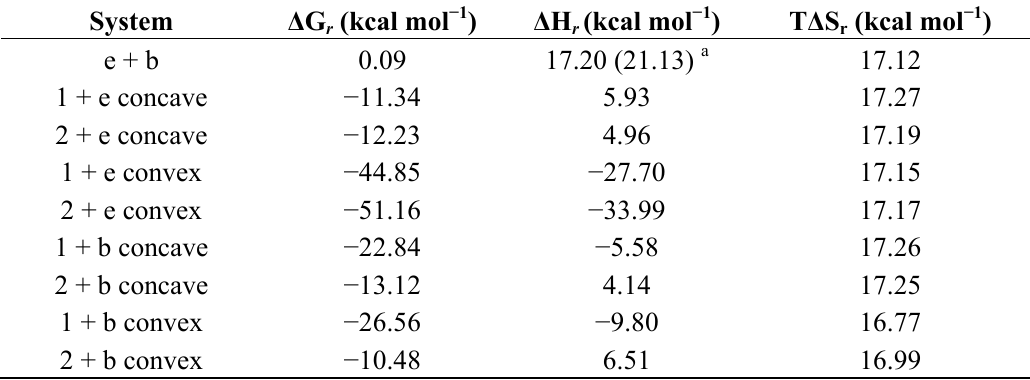
Table 6. Standard Gibbs energy Δ G the dehydrogenation